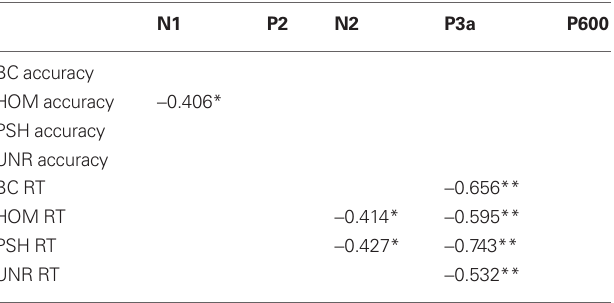
Table 2 | Significant correlations between individual mean amplitudes and behavioral data for each condition.